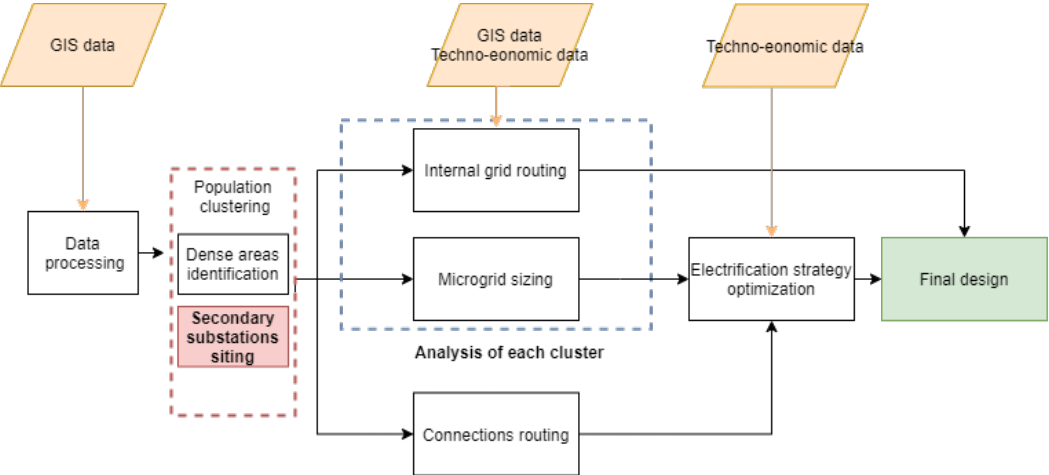
Figure 1. Flow chart of Gisele